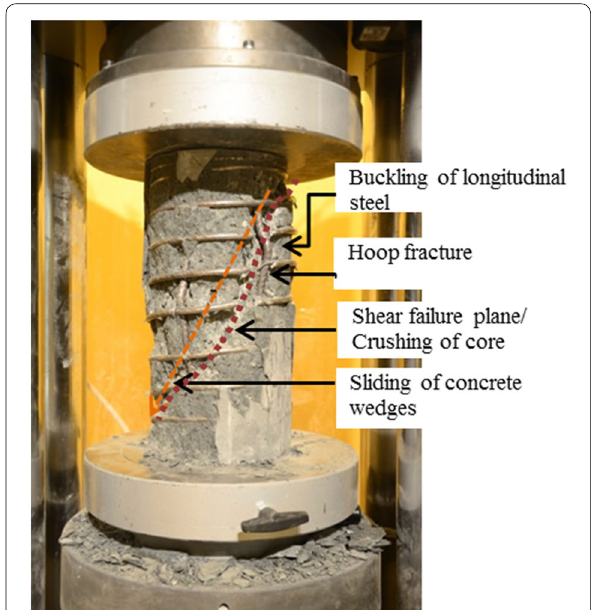
Fig. 2 Failure modes of confined VHSC (Kristombu Baduge